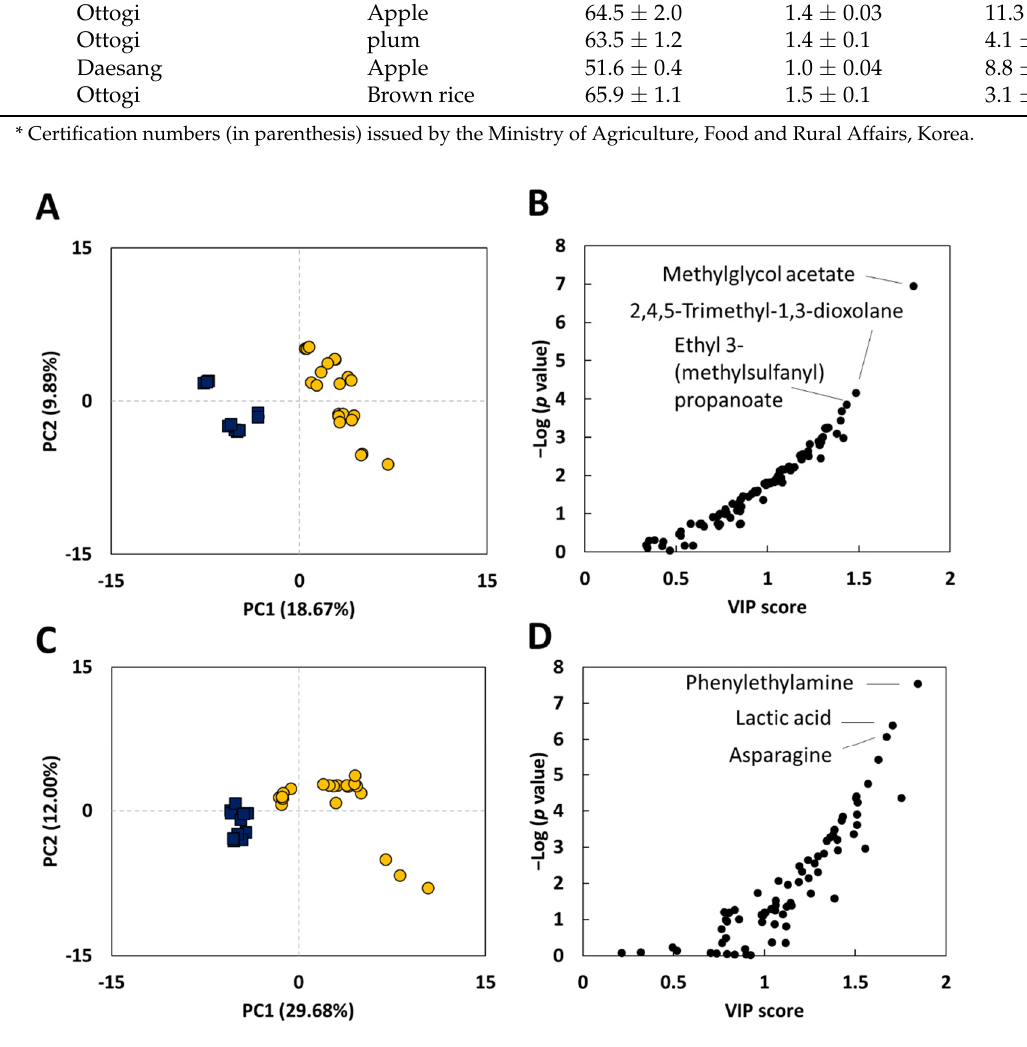
Figure 1. The partial least squares-discriminant analysis (PLS-DA) of the volatile ( A , B ) and nonvolatile ( C , D ) compounds of 11 vinegar samples (Table 1). ( A , C ) Score plots. ( B , D ) variable importance in projection (VIP) scores vs. − Log p -value plots of the 102 volatile ( B ) and 72 nonvolatile ( D ) compounds. Table 2. Number of vinegar metabolites identified.